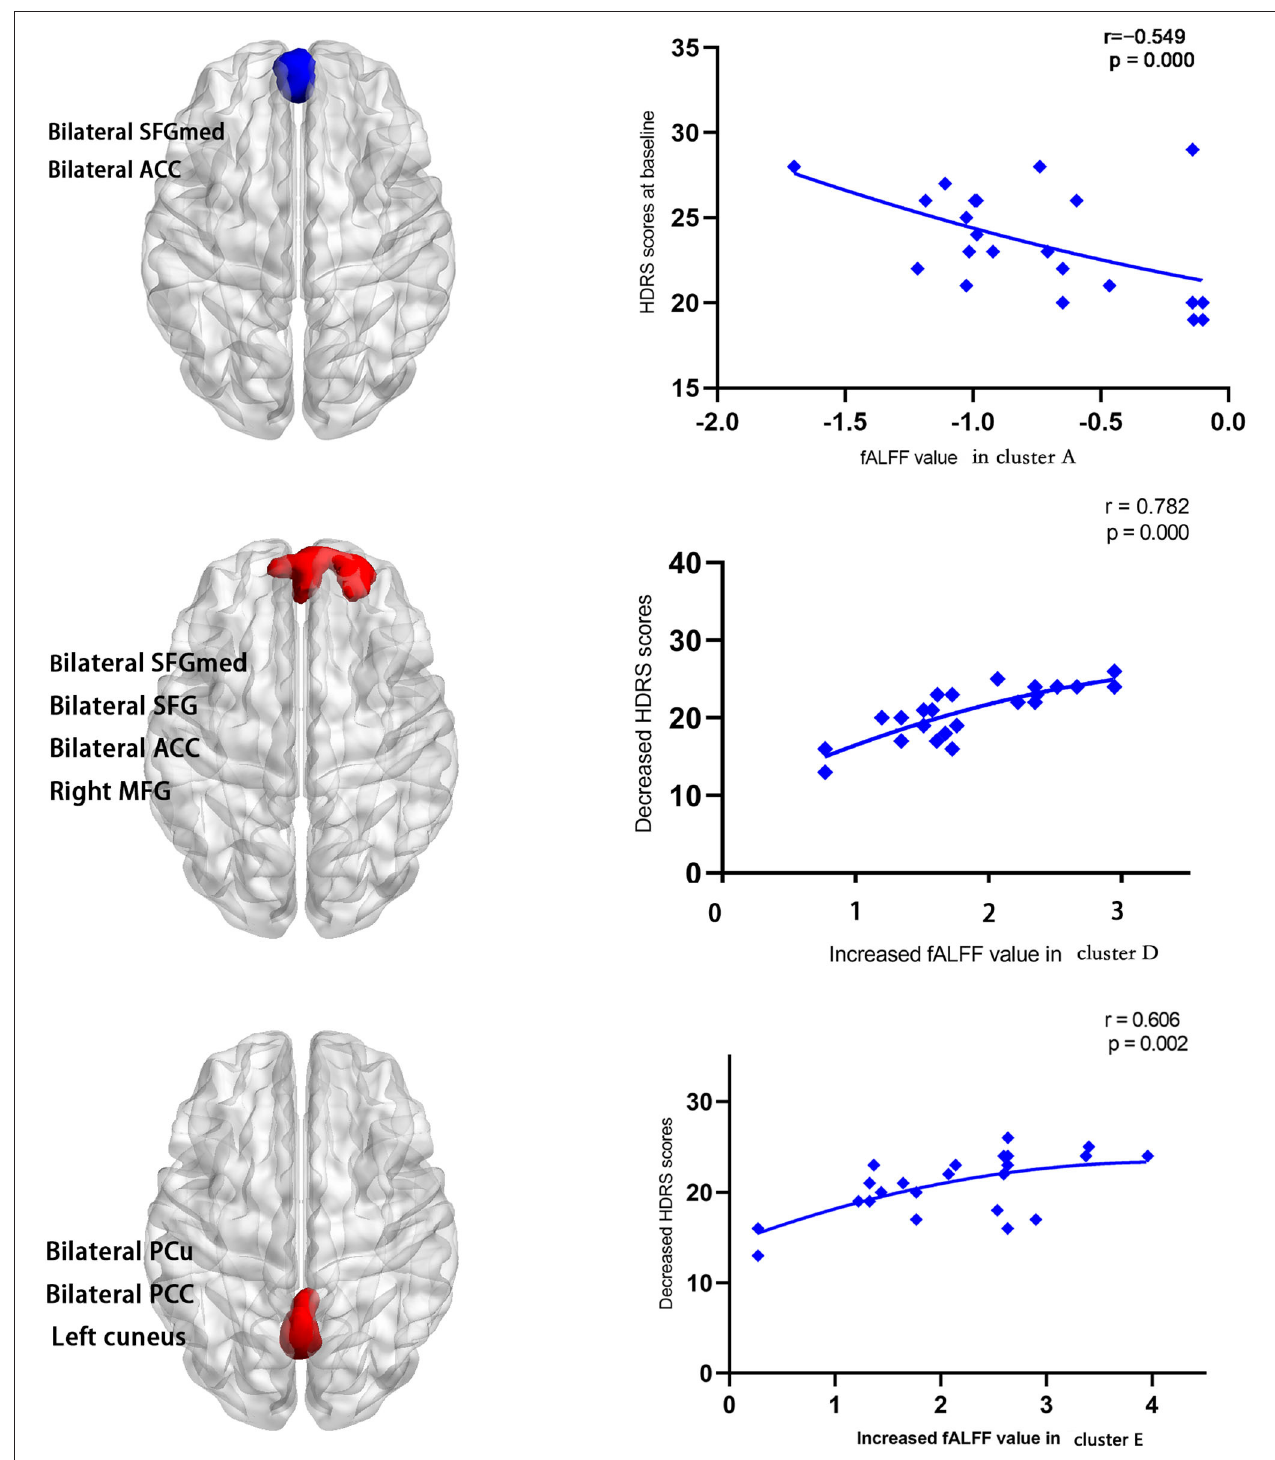
FIGURE 4 | The baseline HDRS scores were negatively correlated with the slow 5 fALFF in bilateral SFGmed and bilateral ACC (cluster A) ( r = − 0.549, p = 0.000) at baseline. Decrease in HDRS scores (baseline HDRS scores minus follow-up HDRS scores) was positively correlated with the increased values in slow 5 fALFF (follow-up minus baseline) in bilateral SFGmed, bilateral SFG, bilateral ACC, and right MFG (cluster D) ( r = 0.782, p = 0.000) and bilateral PCu, bilateral PCC, and left cuneus (cluster E) ( r = 0.606, p = 0.002) at follow-up.